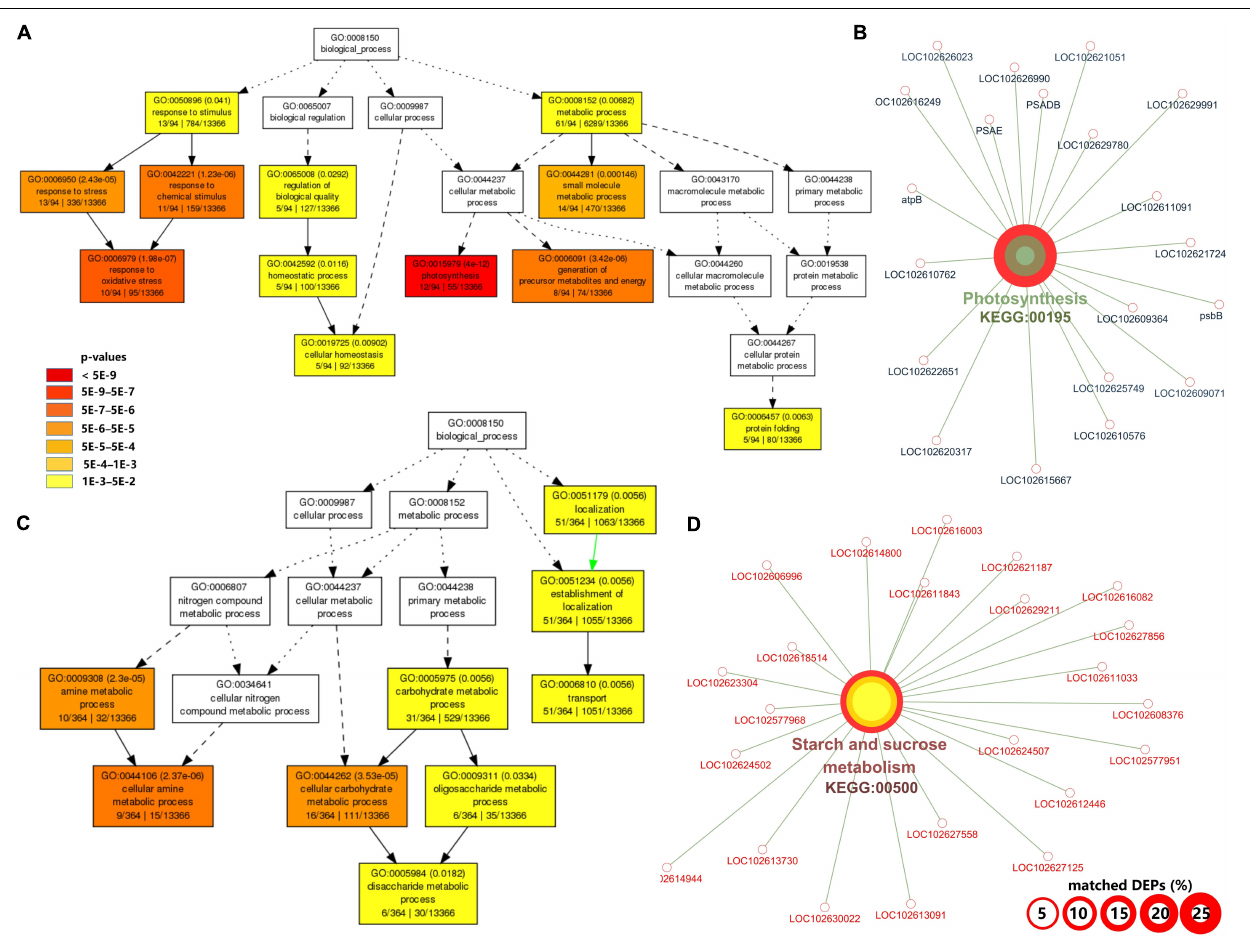
FIGURE 3 | Gene ontology (GO) and Kyoto Encyclopedia of Genes and Genomes (KEGG) pathway enrichment analysis of differentially accumulated proteins (DAPs) between CI2 and MI2. (A,B) Significant GO terms under the category of “Biological Process” for upregulated (A) and downregulated (B) proteins. Statistical test method: hypergeometric, and multi-test adjustment method: Yekutieli (FDR under dependency). (C,D) The significant (term p value < 0.01) KEGG pathways related to upregulated (C) and downregulated genes (D) . The width of the red border represents the proportion of matched DAPs in the corresponding KEGG term